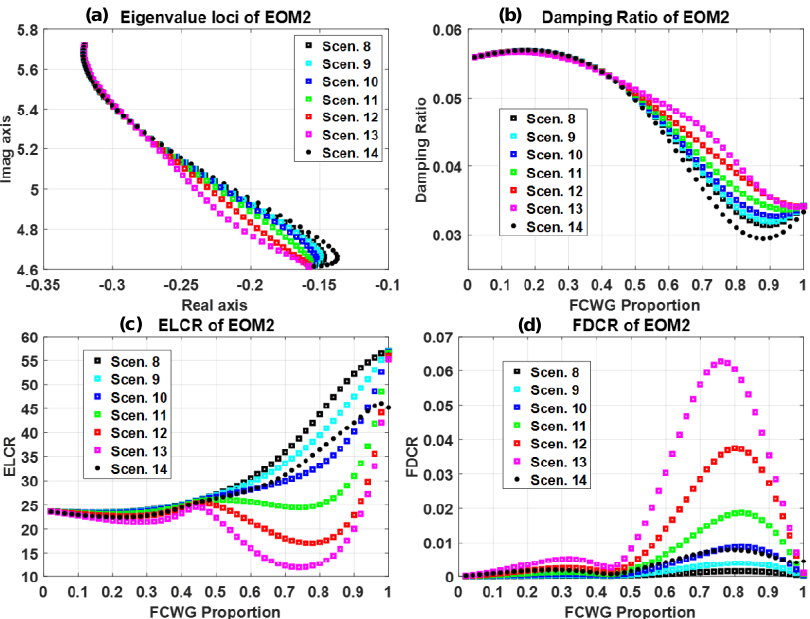
Figure 11. The interaction between DC-FOM and EOM2, considering increasing FCWG proportion: ( a ) eigenvalue loci; ( b ) variation trend of damping ratio; ( c ) variation trend of ELCR; ( d ) variation trend of FDCR.